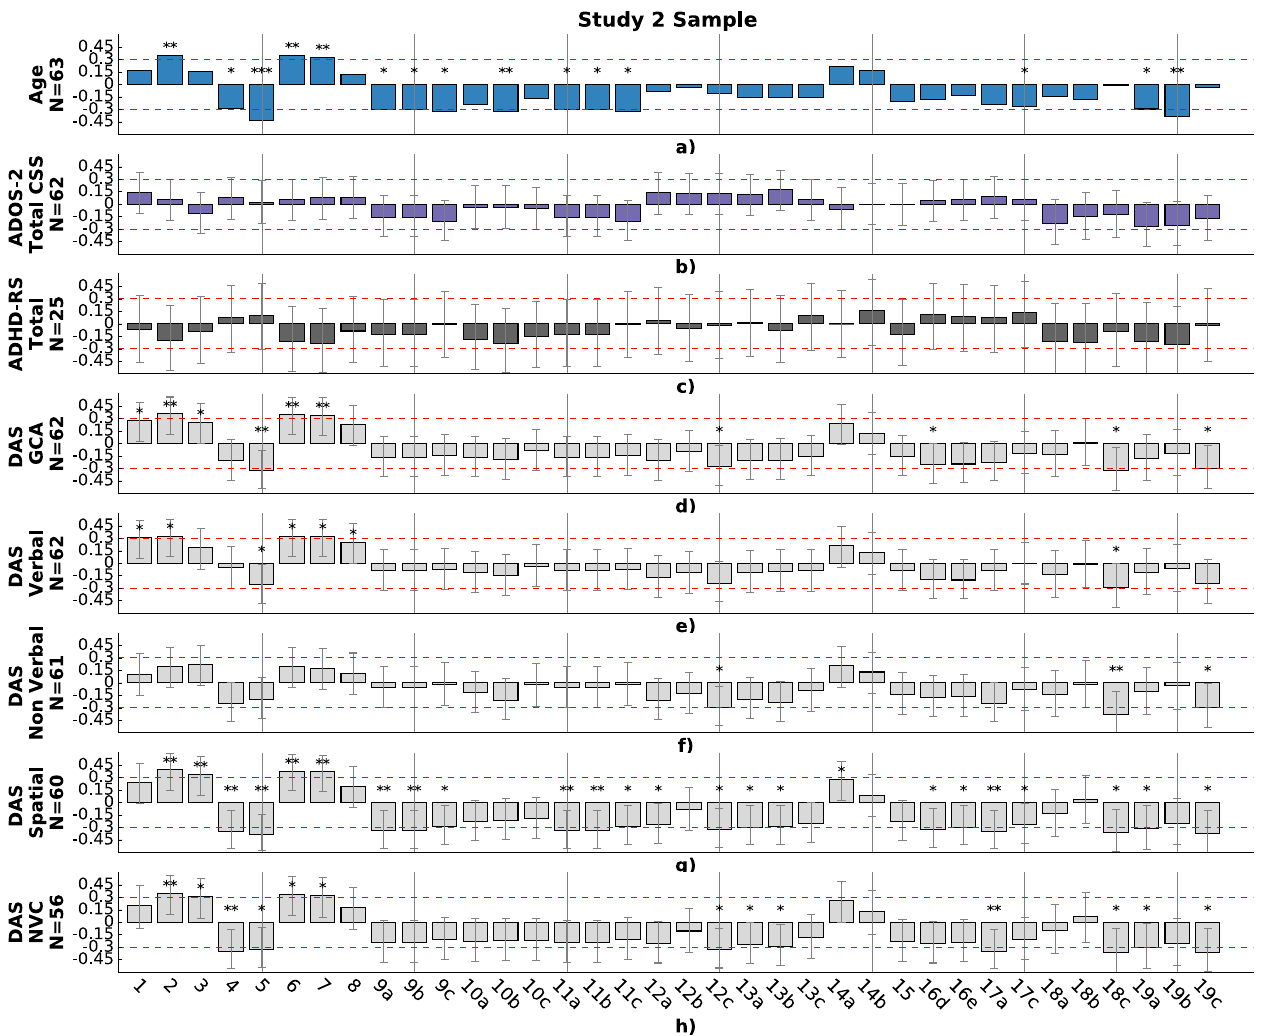
Fig. 6 Correlations between computed motor-related variables (columns) and clinical measures (rows), for the study 2 sample. The height of the bar indicates the value of the partial correlation between a speci fi c game variable and a clinical measure. (1) number of touches ; (2) number of pops ; (3) bubble popping rate; (4) double touch rate ; (5) screen exploratory percentage ; (6) number of targeted ; (7) number of transitions ; (8) repeat percentage ; (9) touch duration ; (10) touch length of the touch motion ; (11) touch velocity ; (12) applied force ; (13) distance to the center ; (14) popping accuracy; (15) average variation of the popping accuracy; (16d) variability of the average popping accuracy ; (16e) variability of the maximum popping accuracy ; (17) number of touches per target ; (18) touch frequency ; (19) time spent on a targeted bubble . a Mean; b Median; c Standard deviation; * P < 0.05; ** P < 0.01; *** P < 0.001. Spearman ’ s rho correlation was used to assess the relationship between motor features and clinical variables, with statistical signi fi cance computed using a Student ’ s t-distribution. Red dotted line indicates level of correlation of .3